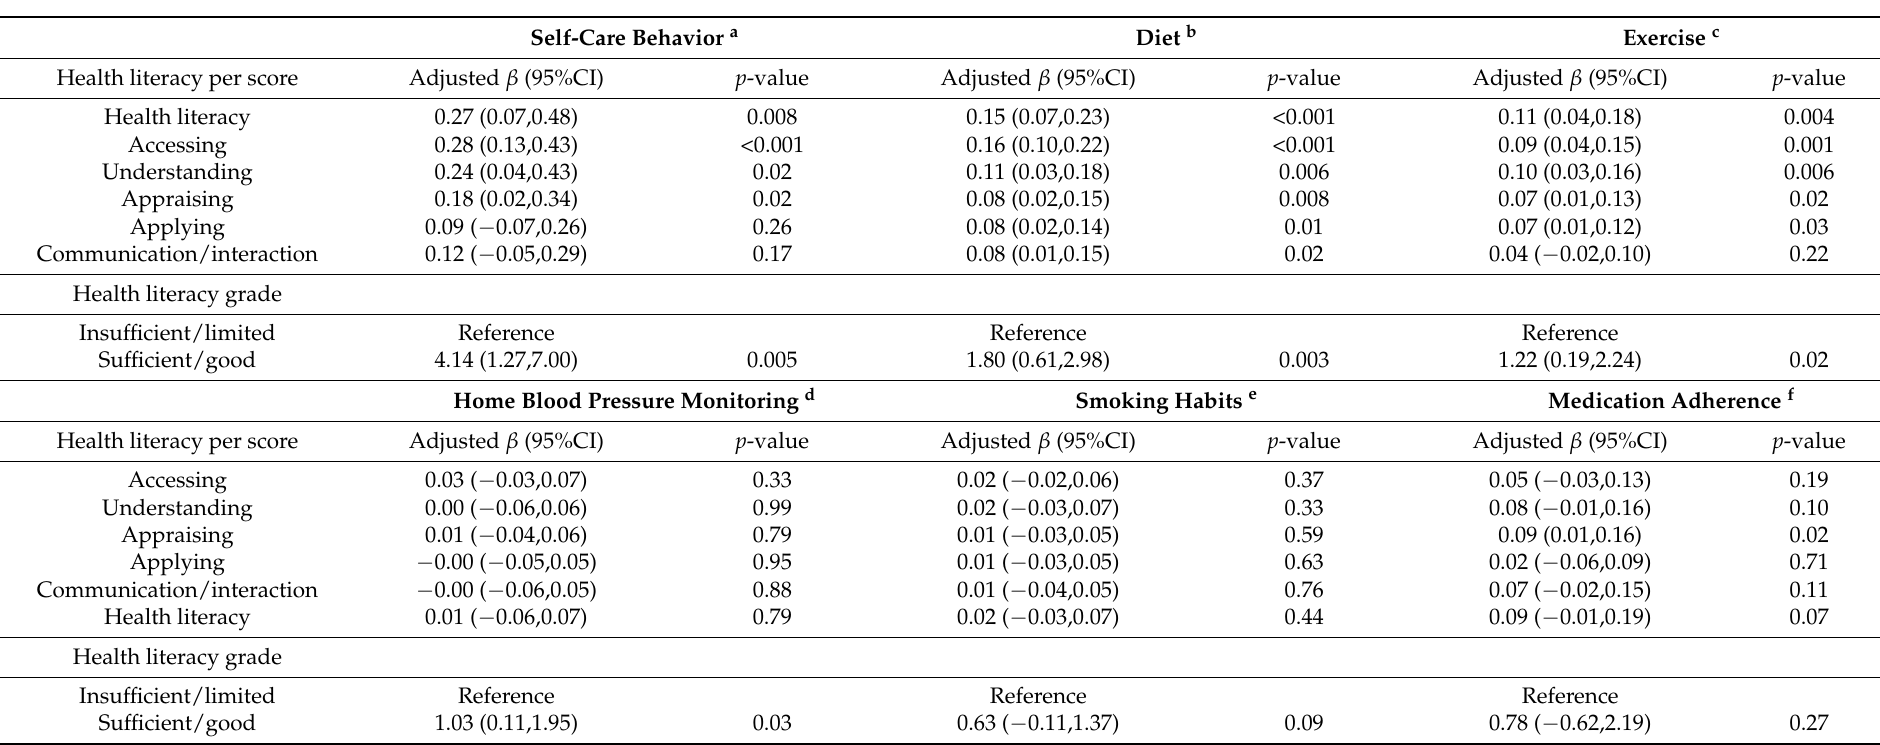
Table 3. The association between different components of health literacy and the 5 domains of self-care behavior in study subjects using multivariable linear regression analysis. Self-Care Behavior a Diet b Exercise c Health literacy per